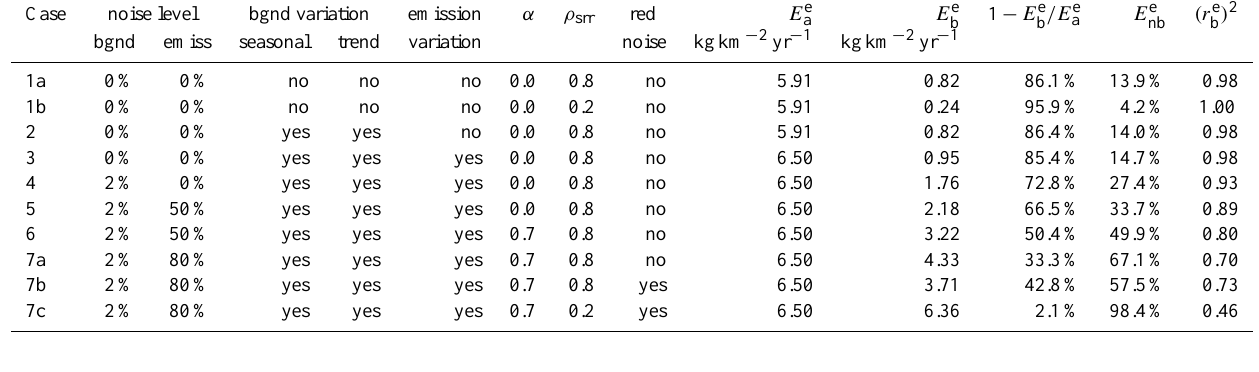
Fig. 4. Time series of the synthetic tracer at Jungfraujoch (a) and Mace Head (b) constructed from the original emission grid.